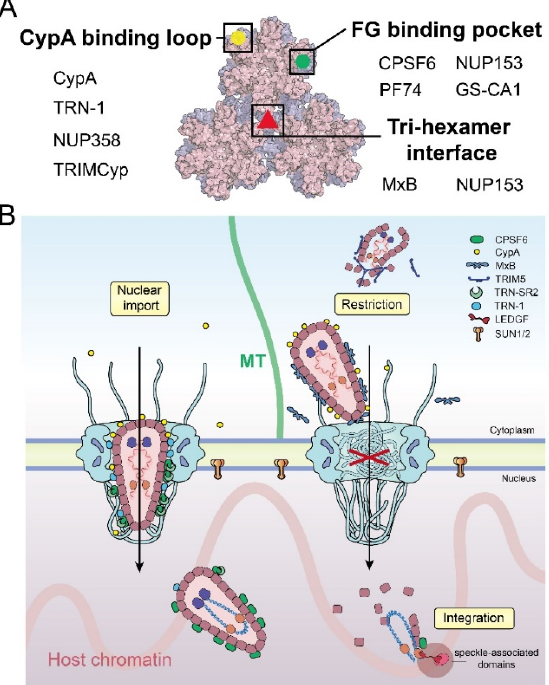
Figure 4. Factors affecting the nuclear import of HIV ‐ 1 capsid. ( A ) Schematic summary of the binding interfaces of HIV ‐ 1 capsid with host factors and inhibitors. Selected key interactors are listed. ( B ) Overview of HIV ‐ 1 capsid–host interactions during nuclear entry.